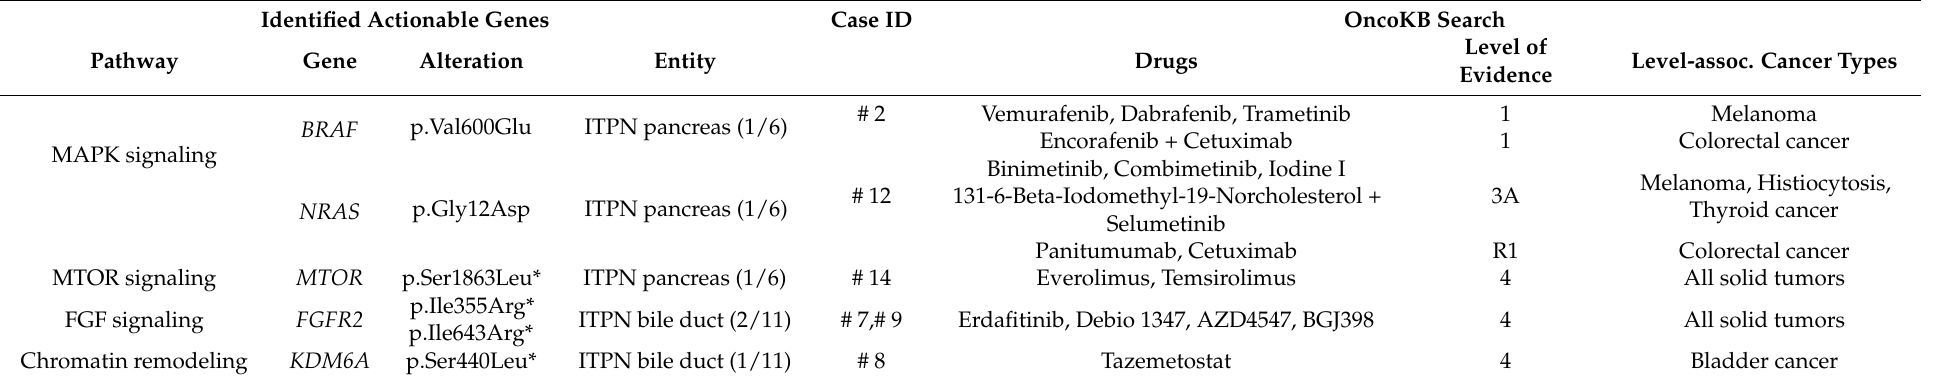
Table 2. Summary of identified known and potential therapeutic targets. The OncoKB database was used to search for actionable therapeutic